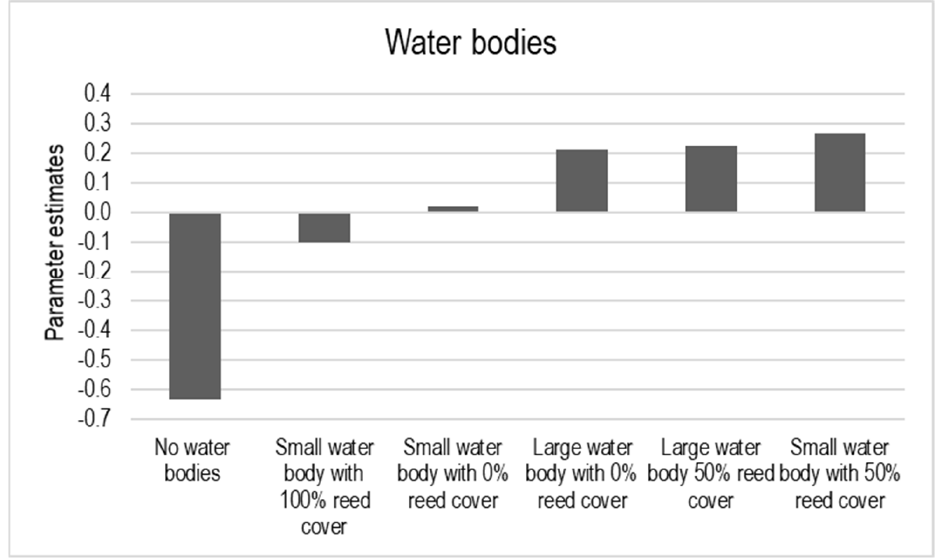
Figure 6. Preferences for water bodies ( n = 520).